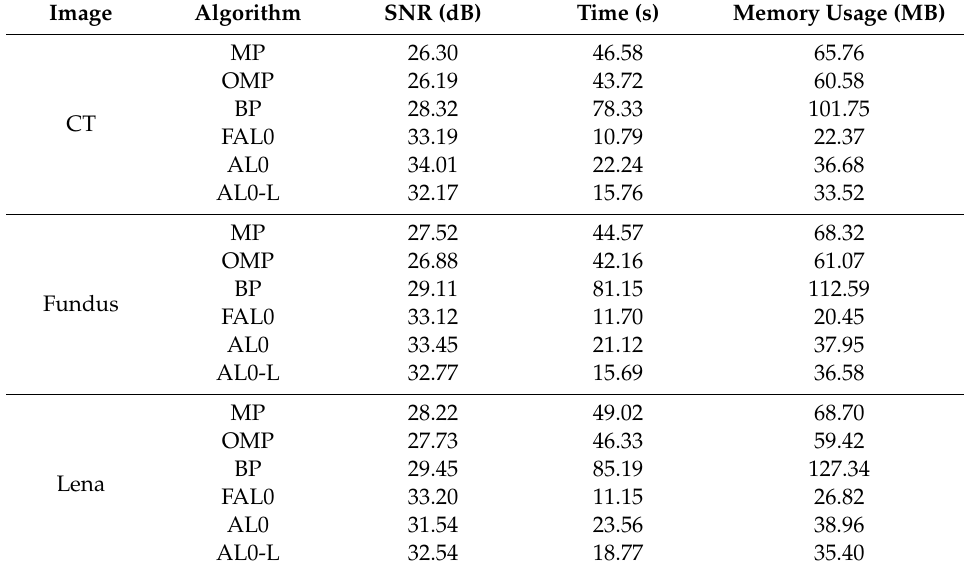
Table 2. Denoising performance of the six